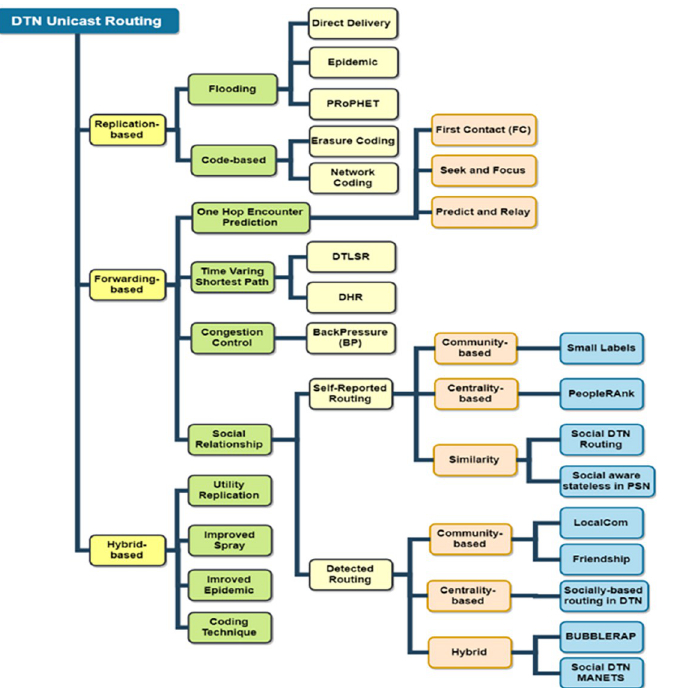
Fig 1. Taxonomy of DTN routing